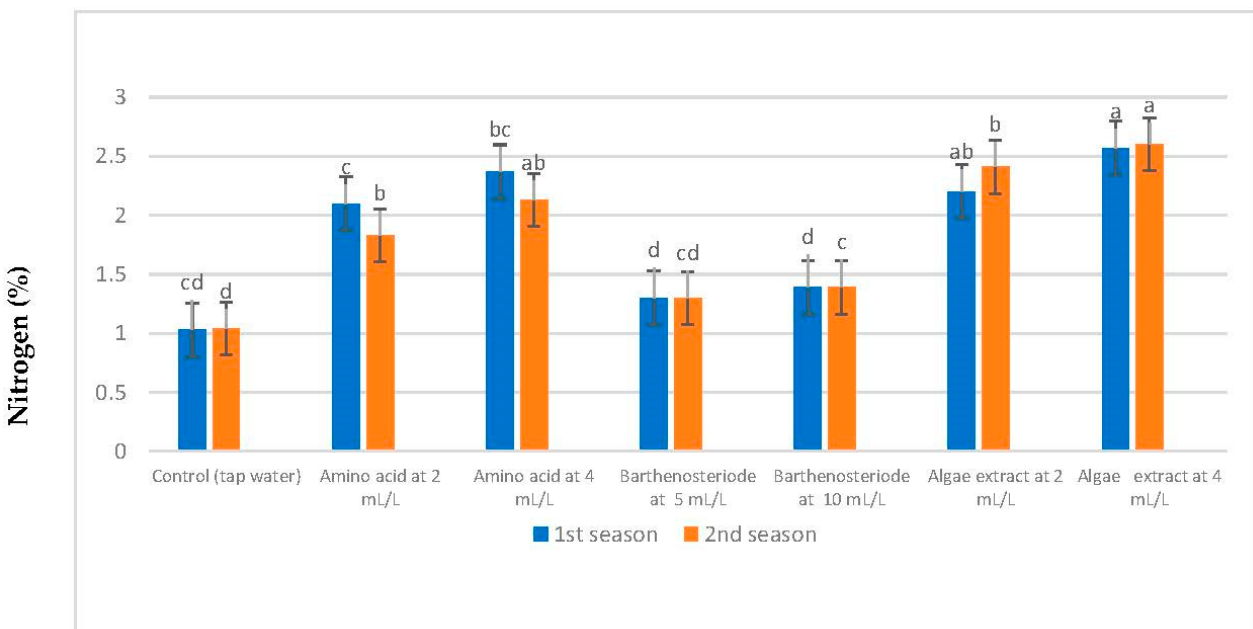
Figure 1. Effect of various bio-stimulant materials on nitrogen (%) of chia (Salvia hispanica L.) plants during the 2019–2020 and 2020–2021 seasons. For the same column, means followed by the same letter are not statistically different, according to the Tukey multiple range test (TMRT) at p ≤ 0.05.